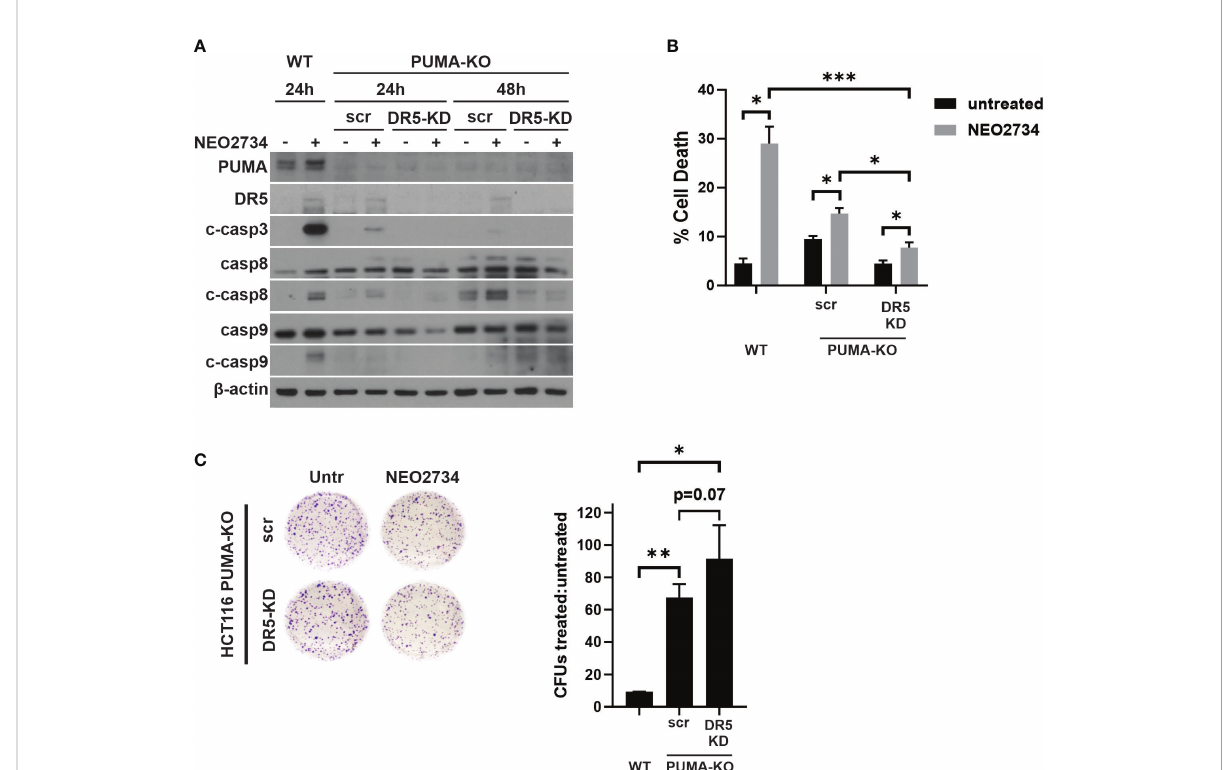
FIGURE 5 NEO2734 activity depends on both PUMA- and DR5- mediated apoptosis. (A) Western blot of indicated HCT116 cell lines after transfection with either scrambled (scr) or DR5 targeted (DR5-KD) siRNA, followed by treatment with NEO2734 10µM. Cells were transfected 24 hours after plating and then treated with drug 24 hours after transfection. Times are the hours of drug treatment. (B) Apoptosis percentage as measured by quanti fi cation of fragmented nuclei in HCT116 parental (WT) and PUMA-KO cells. PUMA-KO cells were transfected with either control (scr) or DR5-targeted siRNA (DR5- KD) at 24 hours after plating, and then treated with drug 24 hours after transfection. All cells were treated with NEO2734 10µM for 48 hours. (C) Crystal violet staining of colony formation assay of HCT116 parental and PUMA-KO cells treated with NEO2734 10µM for 24 h and then replated at 1:400 dilution. Bar graph represents ratio of colonies from NEO2734-treated cultures versus DMSO cultures treated in parallel, for 24 hours. Mean and S.D of 3 independent experiments are shown (*p < 0.05; **p < 0.005; ***p <